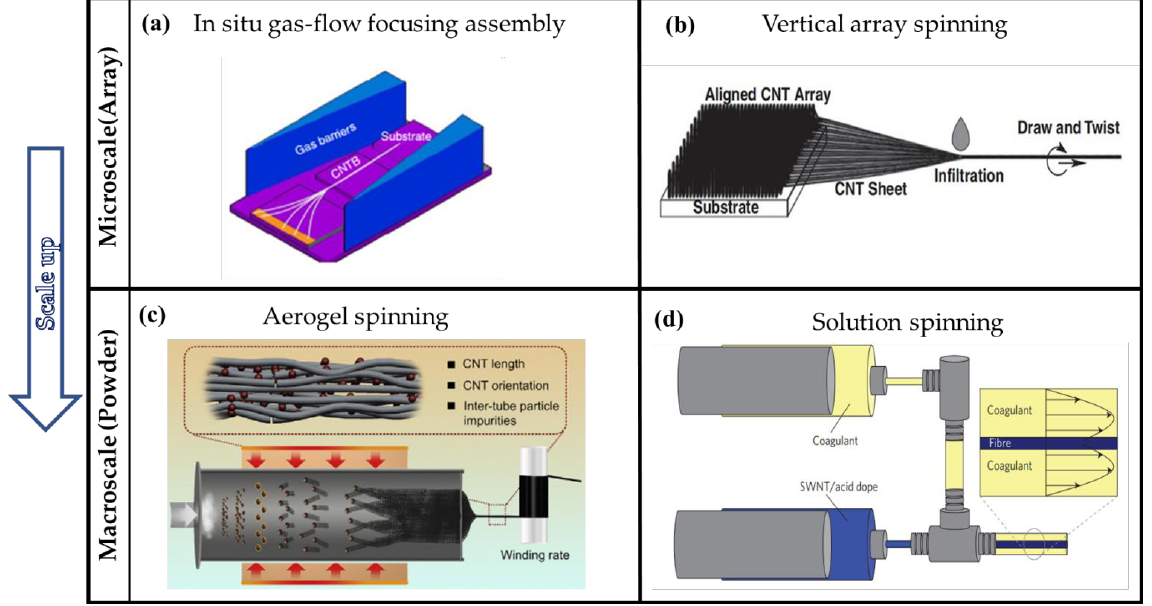
Figure 4. ( a ) Schematic illustration of the in situ fabrication of nanoscale CNTFs by the GFF method. Reproduced with permission from [ 10 ] . Copyright 2018, Springer Nature. ( b ) Schematic diagram of vertical-array spinning. Reproduced with permission from [51]. Copyright 2011, Pergamon-Elsevier Science Ltd. ( c ) Schematic diagram of the continuous synthesis of microscale CNTFs by FCCVD. Reproduced with permission from [ 18 ] . Copyright 2021, Elsevier Sci Ltd. ( d ) Schematic illustration of solution spinning. Reproduced with permission from [52] . Copyright 2009, Springer Nature.